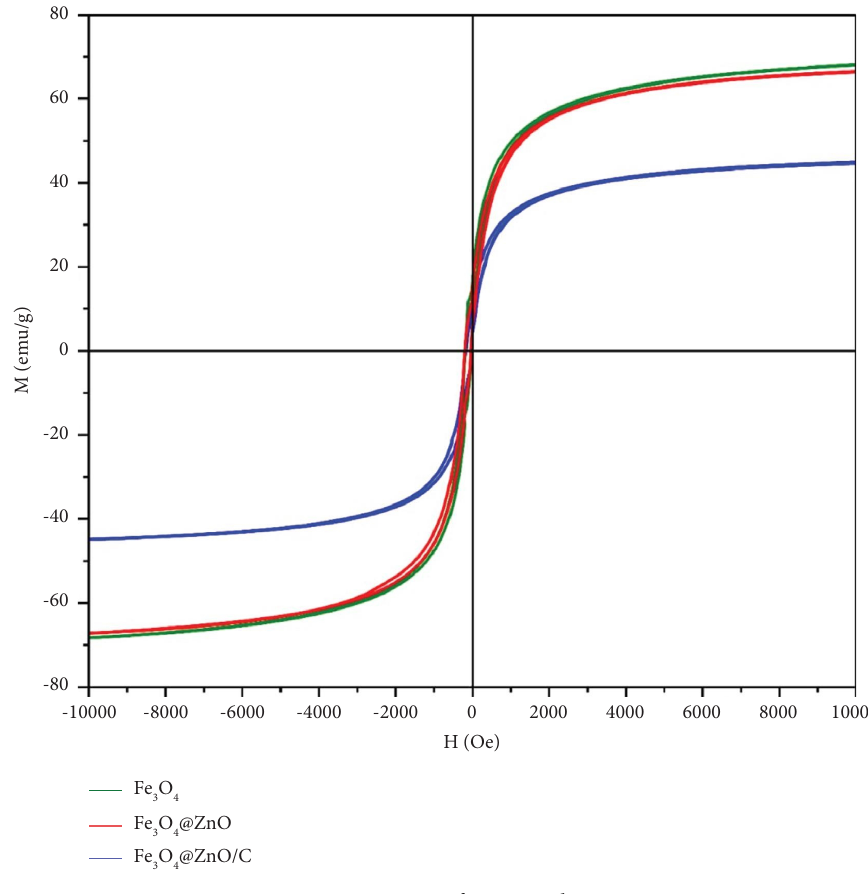
3 O 4 and nanocomposites.